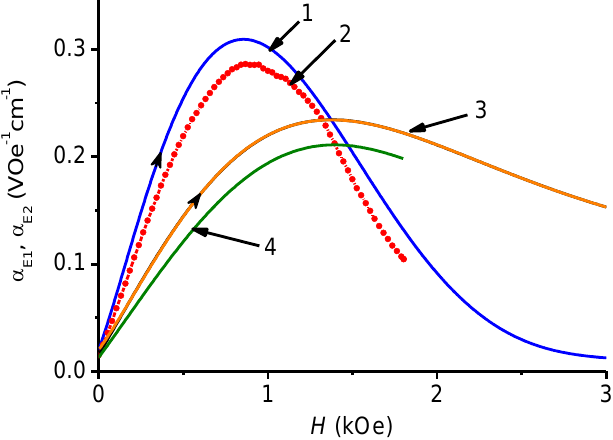
Figure 7. Dependence of the ME coefficients α (1, 2), α (3, 4) on the magnetic field E2 E1 strength H for the CoFe/PZT/CoFe structure obtained by the pulse method (1, 3) and by the HFM method at f = 1 kHz (2, 4). Curves 2 and 3 are measured directly. Curve 1 is calculated from function 3 using the procedure described in the text. Curve 4 is obtained by integrating the function 2 according to Equation (5). The arrows indicate the variation of magnetic field strength H with time. The line connecting the experimental points in curve 2 serves as a guide to the eye. For curves 2 and 4, the range H < 1.8 kOe is limited by the experimental